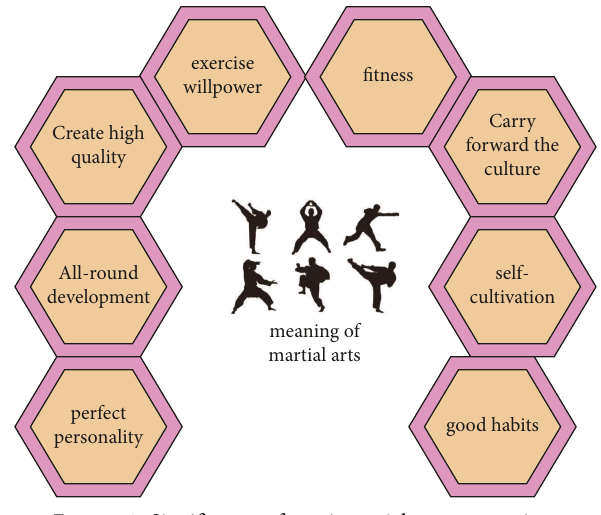
Figure 1: Significance of emei martial arts